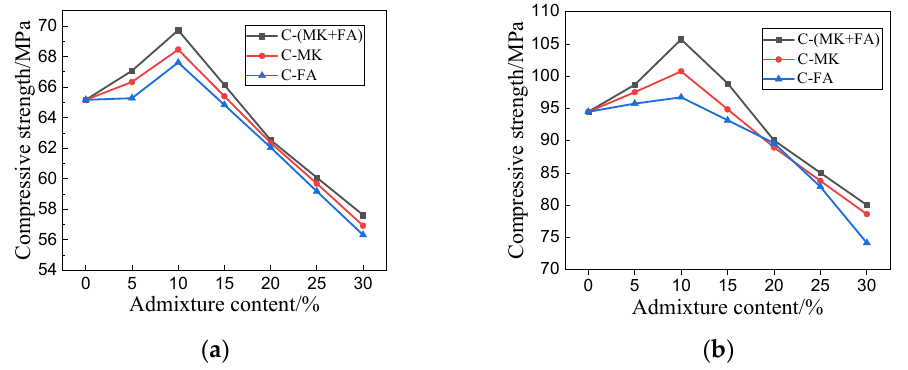
Figure 4. Compressive strength of hardened MOSC after different curing durations: ( a ) 3 days; ( b ) 28 days.